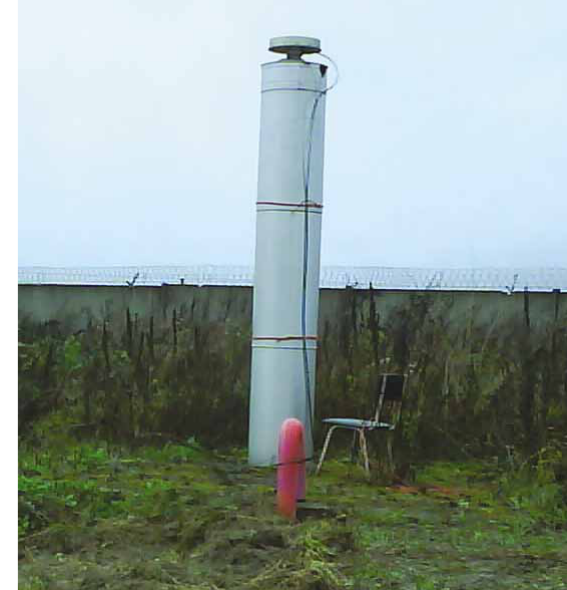
Fig. 3. VLNS pier and GPS antenna